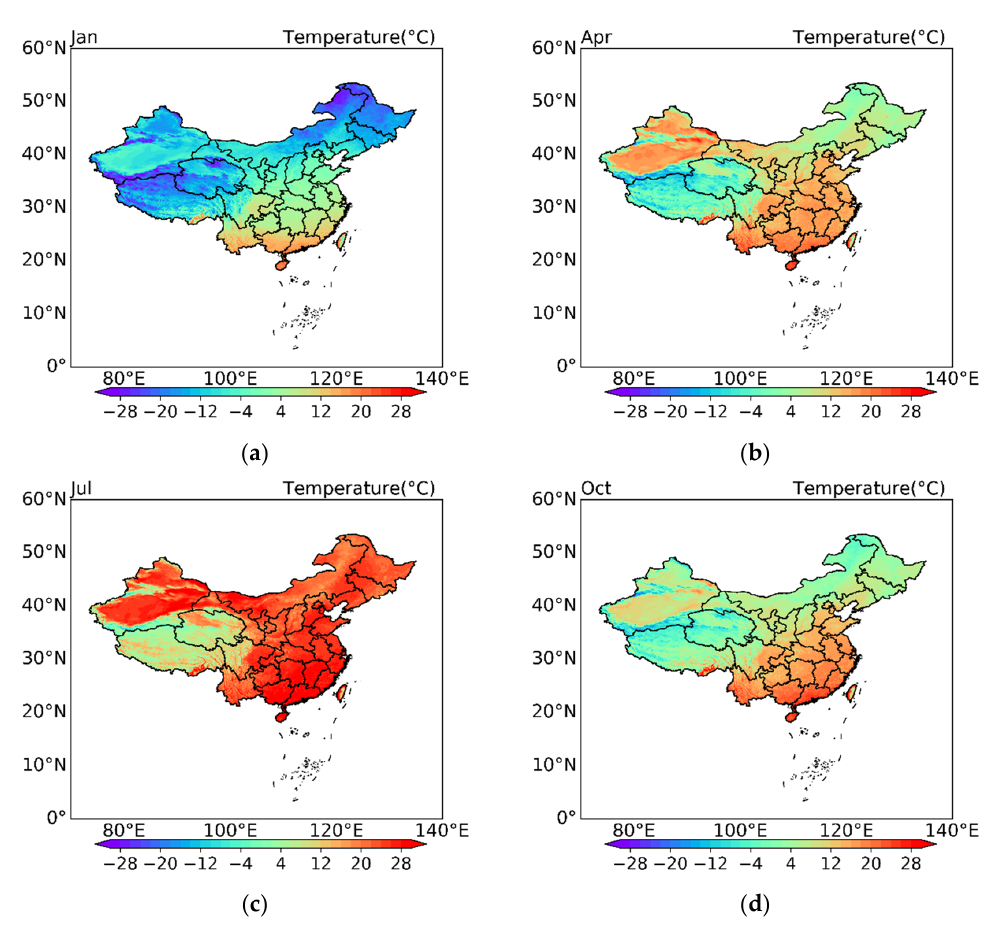
Figure 2. Spatial patterns of monthly mean temperature in 2020: ( a ) spatial patterns of January mean temperature in 2020; ( b ) spatial patterns of April mean temperature in 2020; ( c ) spatial patterns of July mean temperature in 2020; ( d ) spatial patterns of October mean temperature in 2020.